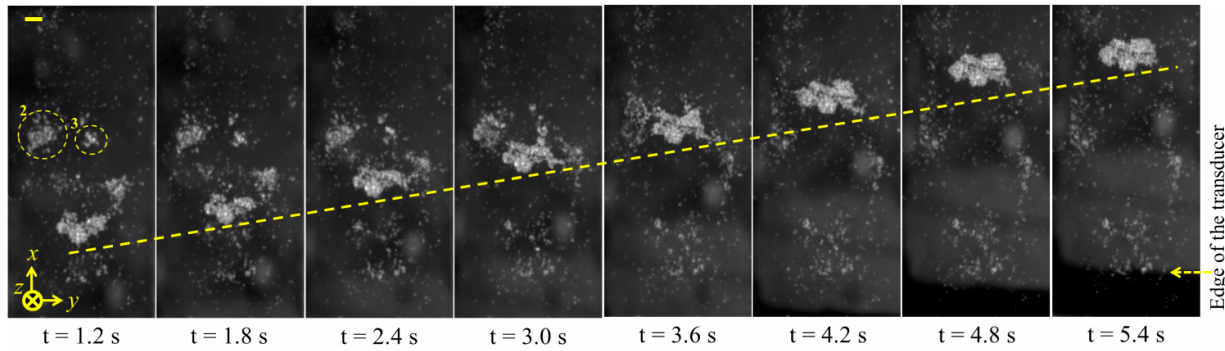
Figure 17. Image sequences of the transportation of the trapped agglomerate by moving the curved transducer in the direction of X-axis . Scale bar = 100